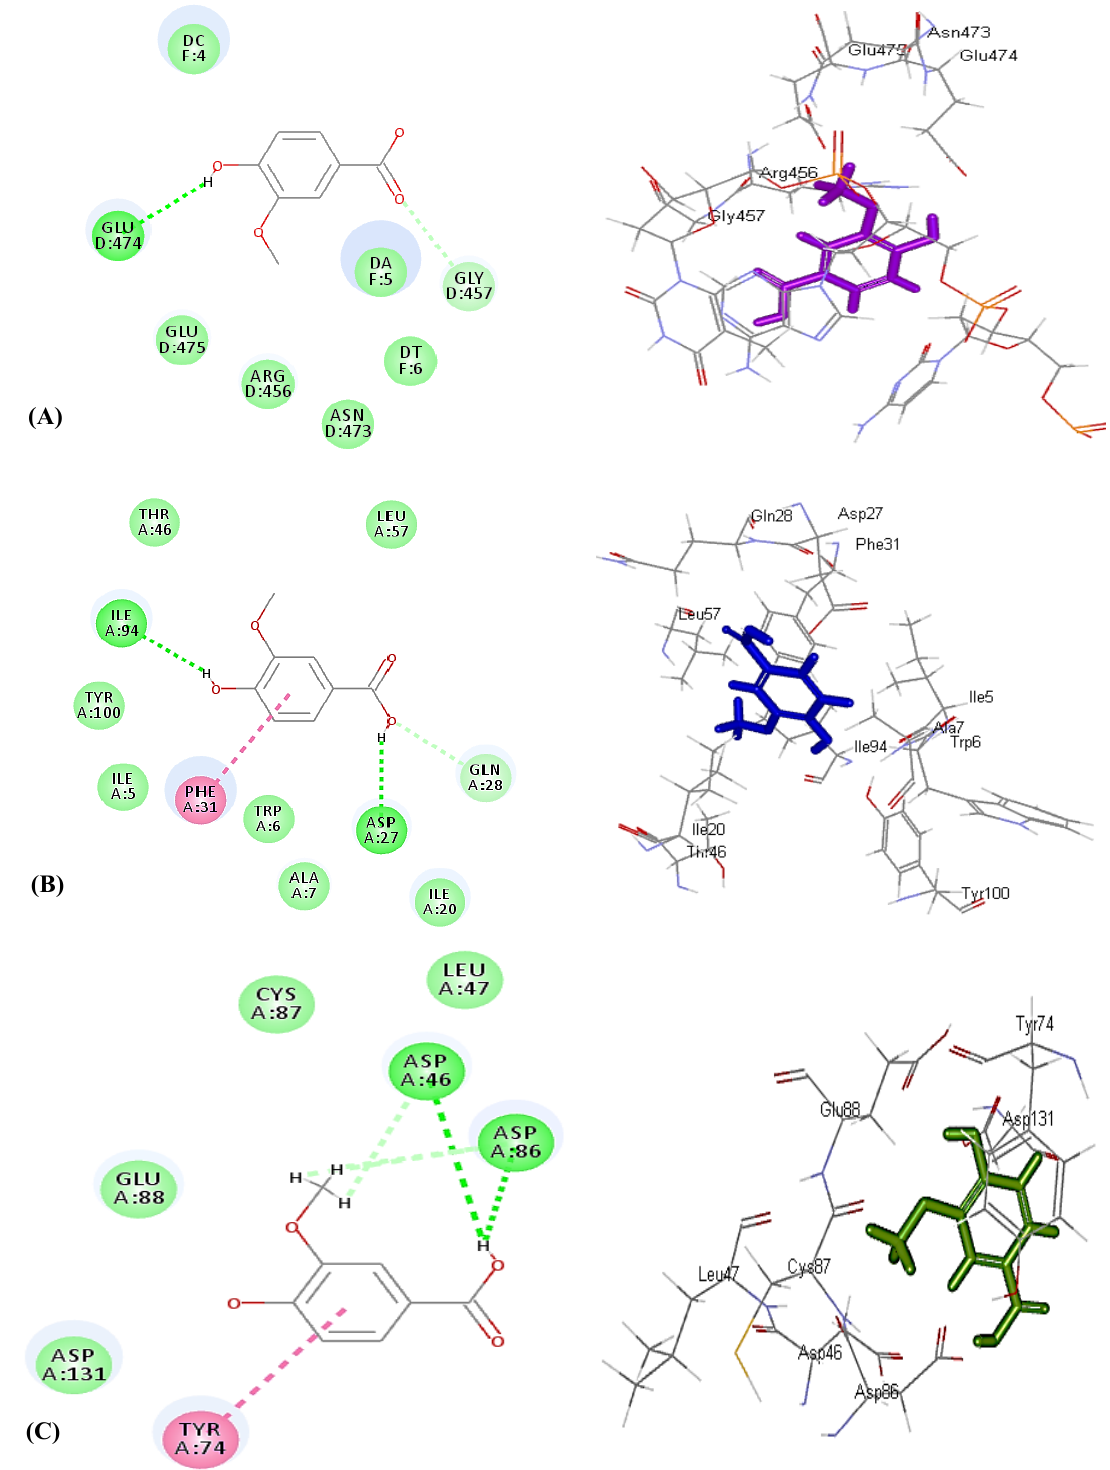
Figure 3. Two-dimensional and 3D binding mode of vanillic acid ( 2 ) within the active site of DNA-gyrase ( A ), dihydrofolate reductase ( B ), and Aminoglycoside nucleotidyltransferase ( C ). Concerning enzymes involved in the occurrence and dissemination of cancerous cells, vanillic acid effectively inhibited both human cyclin-dependent kinase 2 (CDK-2) and DNA topoisomerase II with a high fitting score estimated by ∆ G of − 30.22 and − 22.07 kcal/mole, respectively, approaching the co-crystalized ligand for the